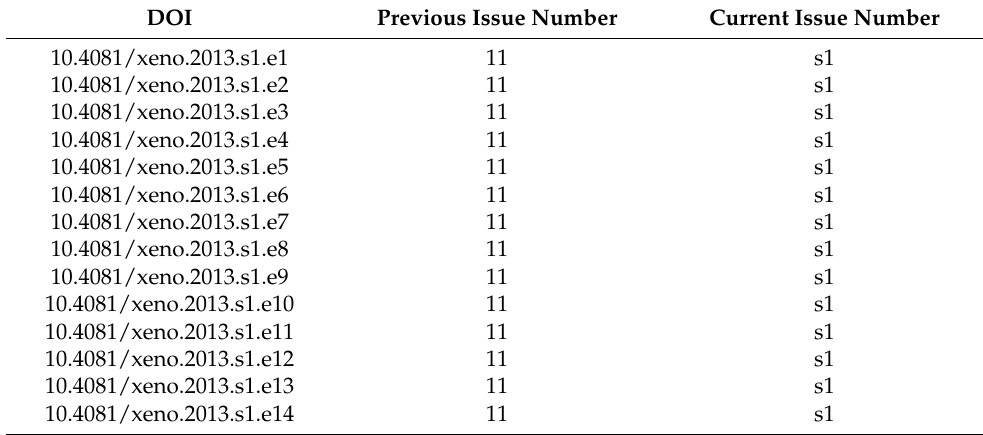
Table 2. MDPI’s corrected Issue Numbers for 14 articles in Volume